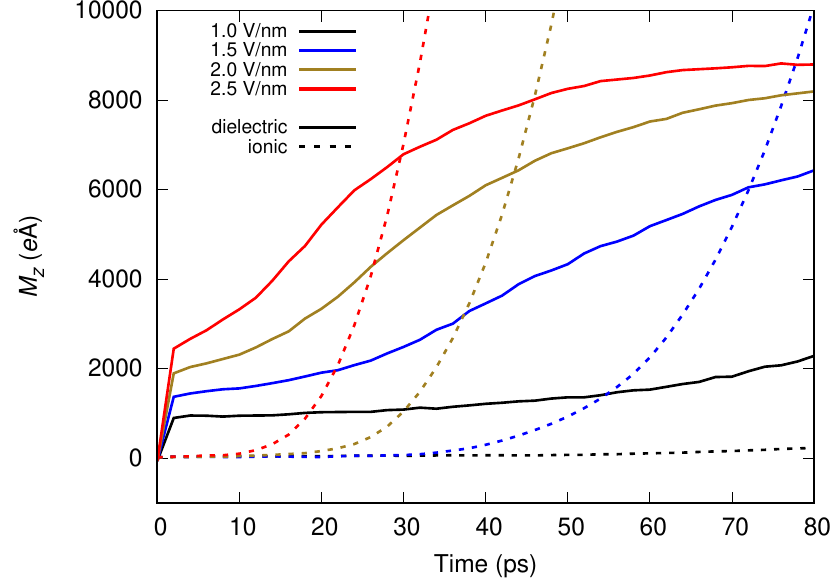
Figure 22. The z -component, M z , of dipole moments generated by molecules (blue) and ions (magenta) for different intensities of the applied field (distinguished by line colors according to the legend). Results for the system with eight 5.26-kDa PEG chains and 18 NaCl ion pairs are shown. Plotted with gnuplot